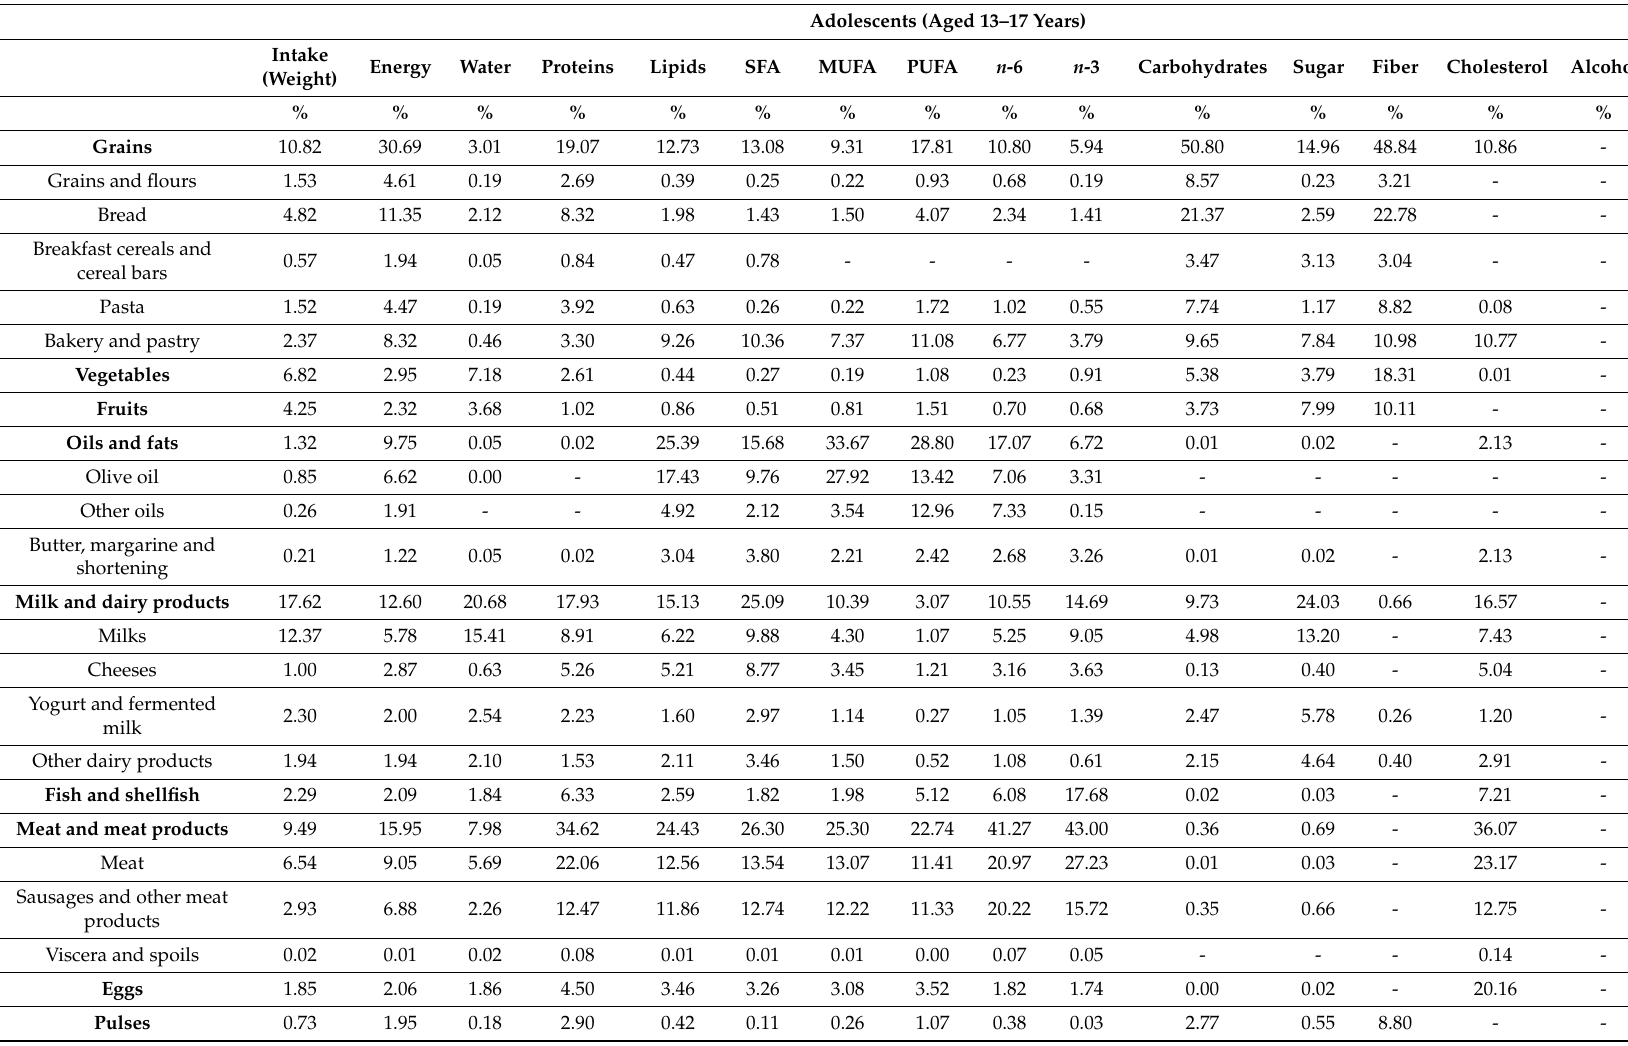
Table 5. Dietary sources of nutrients (%) from food groups/subgroups in the Spanish ANIBES study population: adolescents aged 13–17 years ( n =